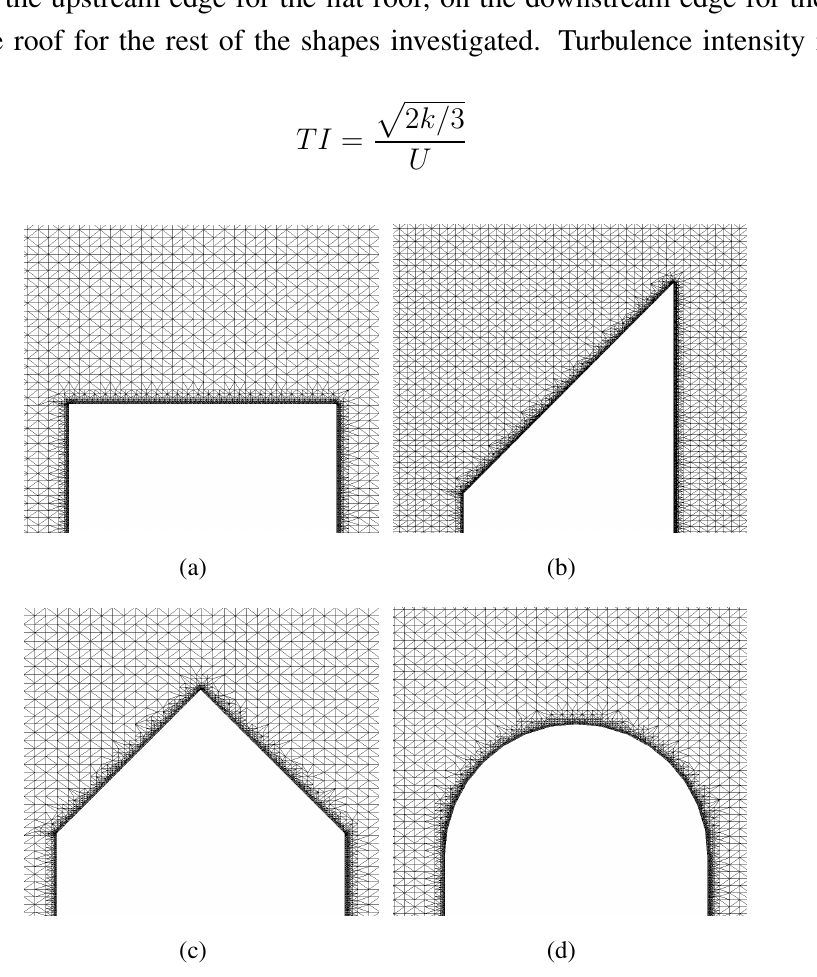
Figure 10. Vertical section detail of the refined meshes obtained using snappyHexMesh for the state-of-the-art analysis. ( a ) Flat roof, 6.7 M cells ( y + ≈ 325 ); ( b ) shed, 6.4 M cells ( y + ≈ 355 ); ( c ) pitched, 6.5 M cells ( y + ≈ 337 ); ( d ) spherical (6.4 M cells, y + ≈ 338 )/vaulted (6.6 M cells, y + ≈ 334